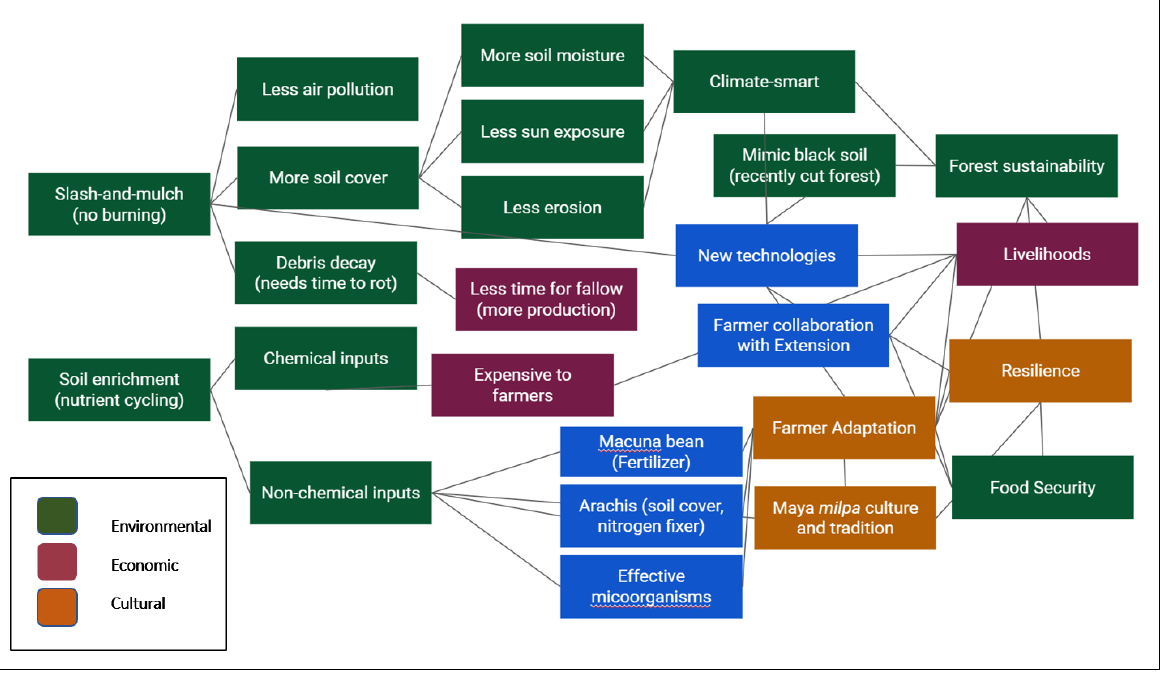
Figure 2. A Variation of Ostrom’s Socio-Ecological Systems Model, Adapted Using this Study’s Perception Data on Environmental, Economic, and Cultural Linkages to Slash-and-Burn and Soil Enrichment Practices in the Milpa Farming System in Southern